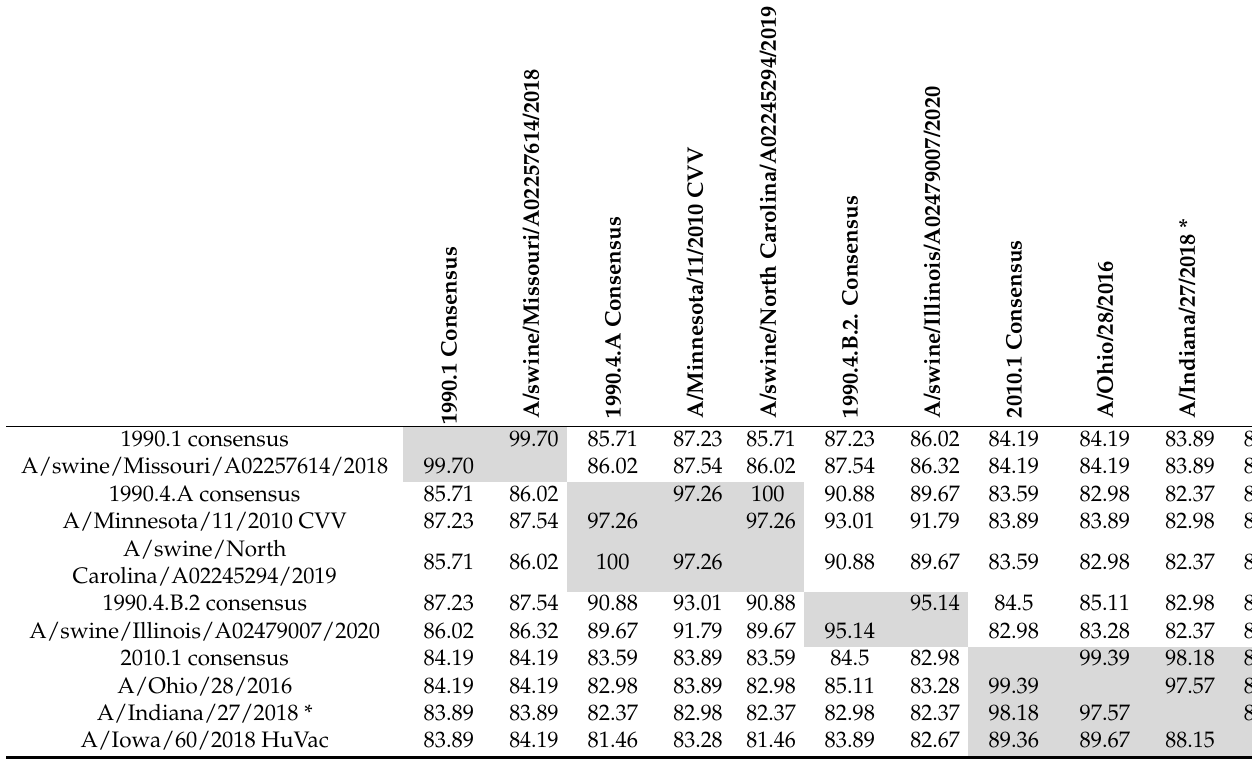
Table 1. Pairwise amino acid sequence similarity of the HA1 domain from swine H3 clade consensus sequences from the U.S. to candidate vaccine viruses or human seasonal vaccine viruses and clade representative viruses used in this study. Within-clade comparisons are highlighted in